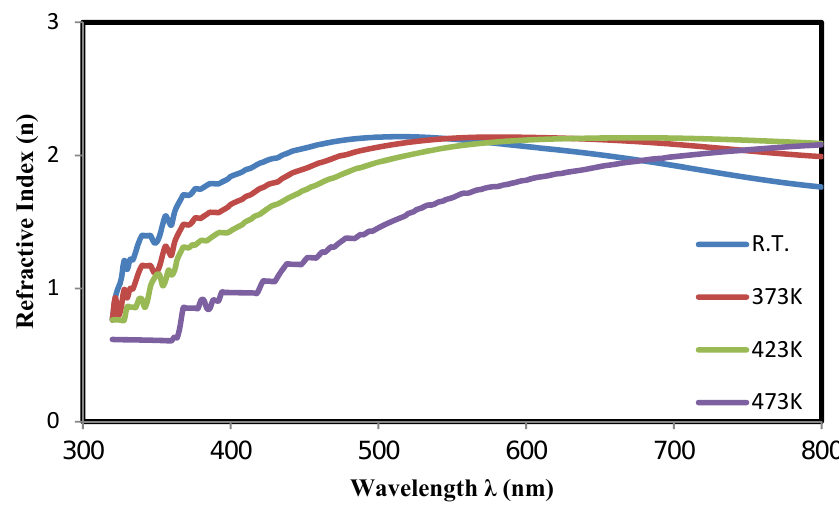
Fig. 5: The variation of refractive index with wavelength for NiO